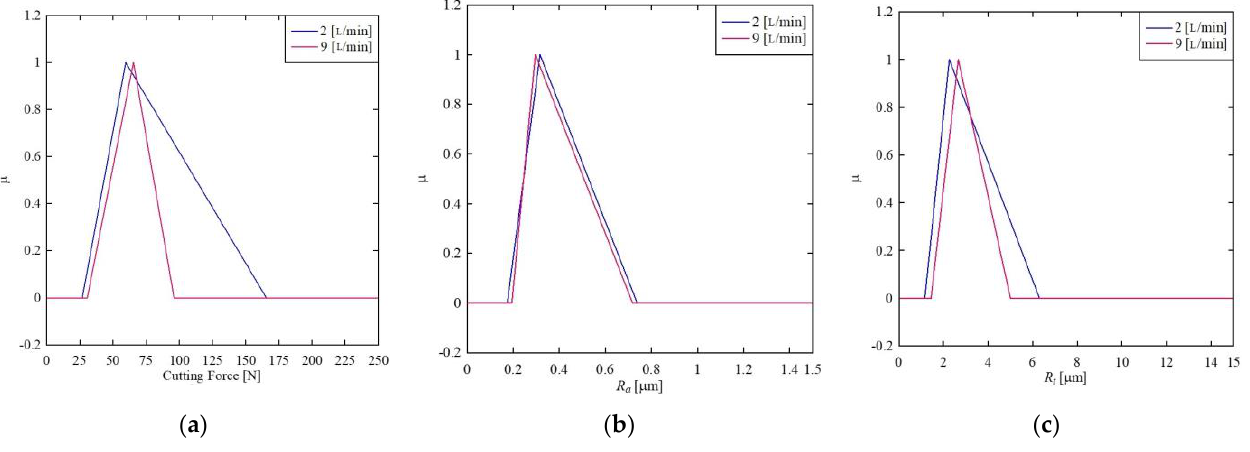
Figure 3. Effect of coolant flowrate on ( a ) cutting force ( b ) R a ( c ) R t .